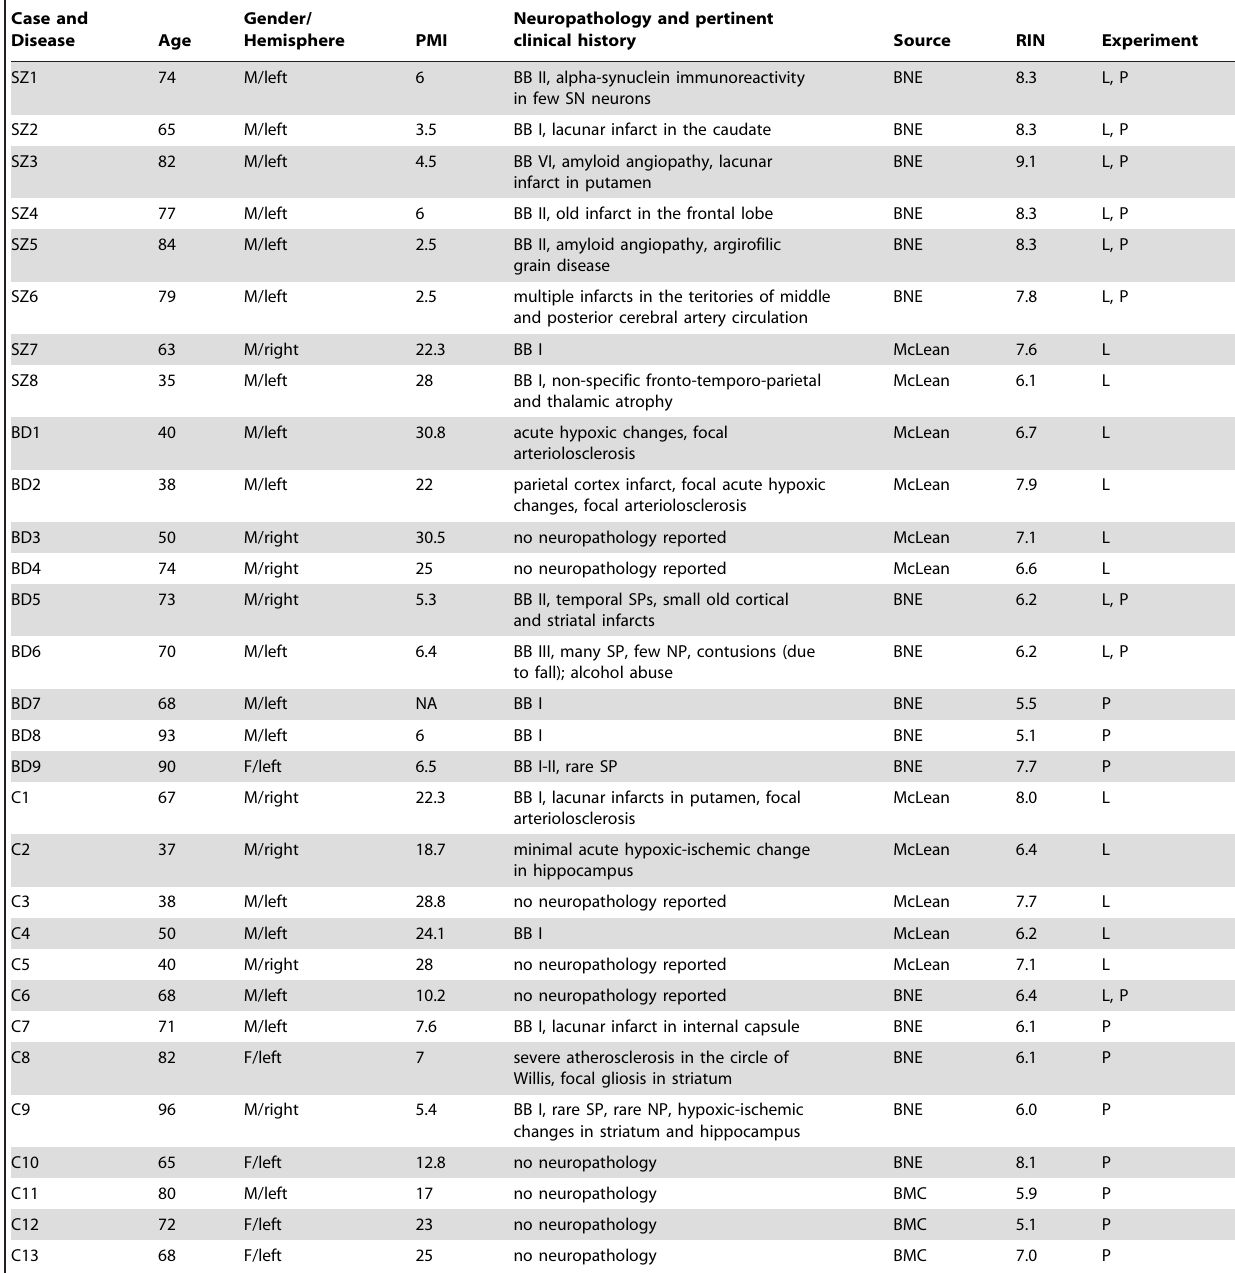
Table 1. Analyzed human prefrontal cortices